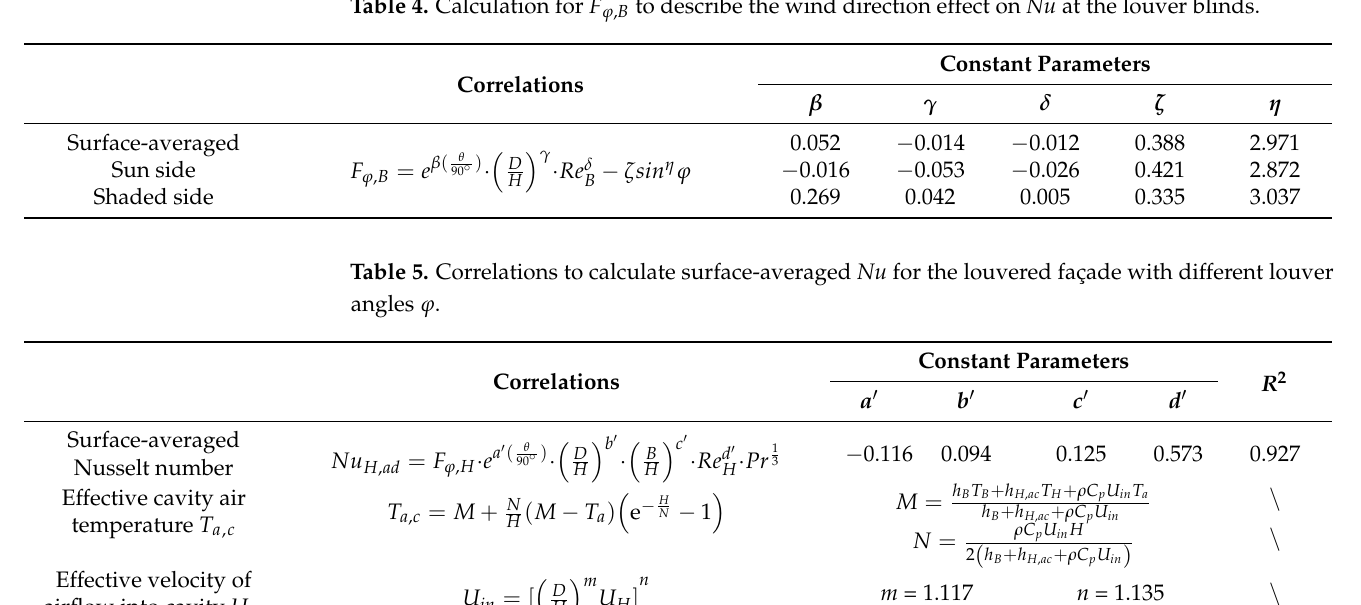
Table 4. Calculation for F ϕ , B to describe the wind direction effect on Nu at the louver blinds.